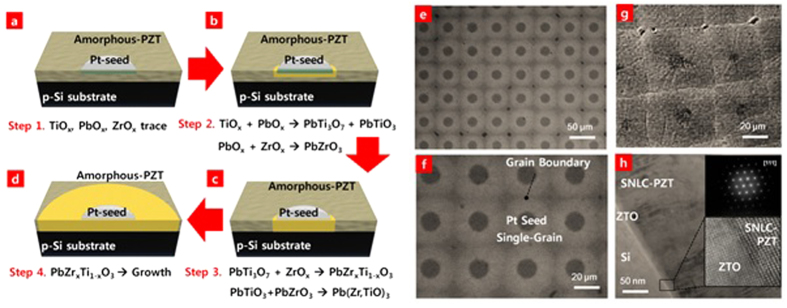
SNLC-PZT grain-growth mechanism.Schematic illustration of (a) 1-step: formation of TiOx and PbOx traces, (b) 2-step: reaction of TiOx, PbOx and ZrOx for PbTiO3 and PbZrO3, (c) 3-step: nucleation of PZT seed formation and (d) 4-step: rosette grain-growth by PbTiO3 migration. Observation of Pt-dot array and its crystal-PZTs by magnitude microscope in (e,f). FE-SEM image of SNLC-PZT grains and its multi-layer cross-section observed by HR-TEM and the corresponding SNLC-PZT diffraction pattern.